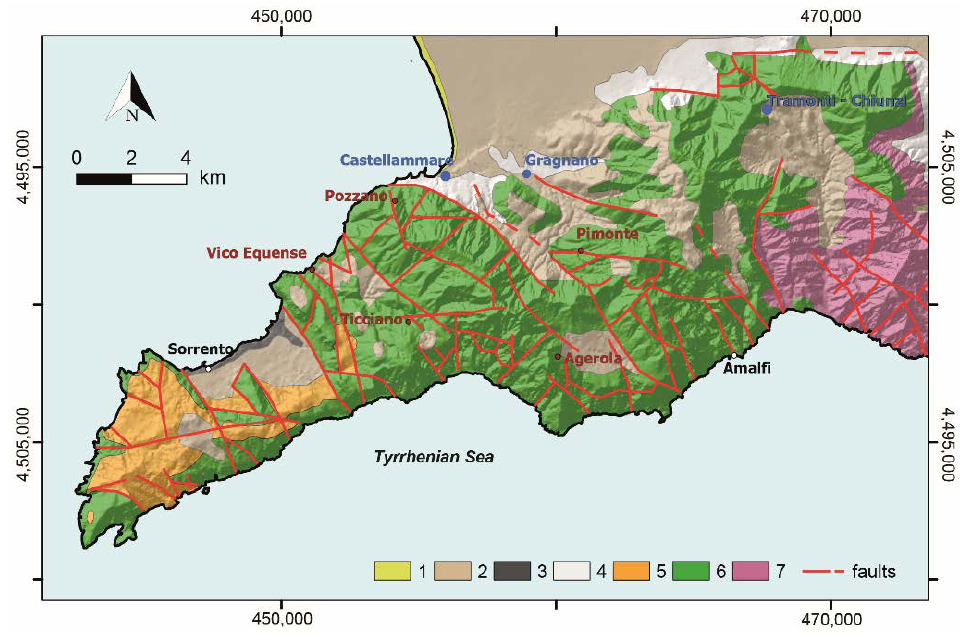
Figure 6. Lithological sketch of the Sorrento Peninsula. Key: (1) beach deposit (Holocene); (2) pyroclastic fall deposit (late Pleistocene–Holocene); (3) Campanian ignimbrite (late Pleistocene); (4) detrital alluvial deposit (Pleistocene); (5) flysch deposit (Miocene); (6) limestone (Mesozoic); (7) dolomitic limestone (Mesozoic). Red lines mark the main faults; red circles and red labels, the sites affected by shallow landslide activations; blue circles, the rain gauges; white circles, the main localities (after [17], mod.).